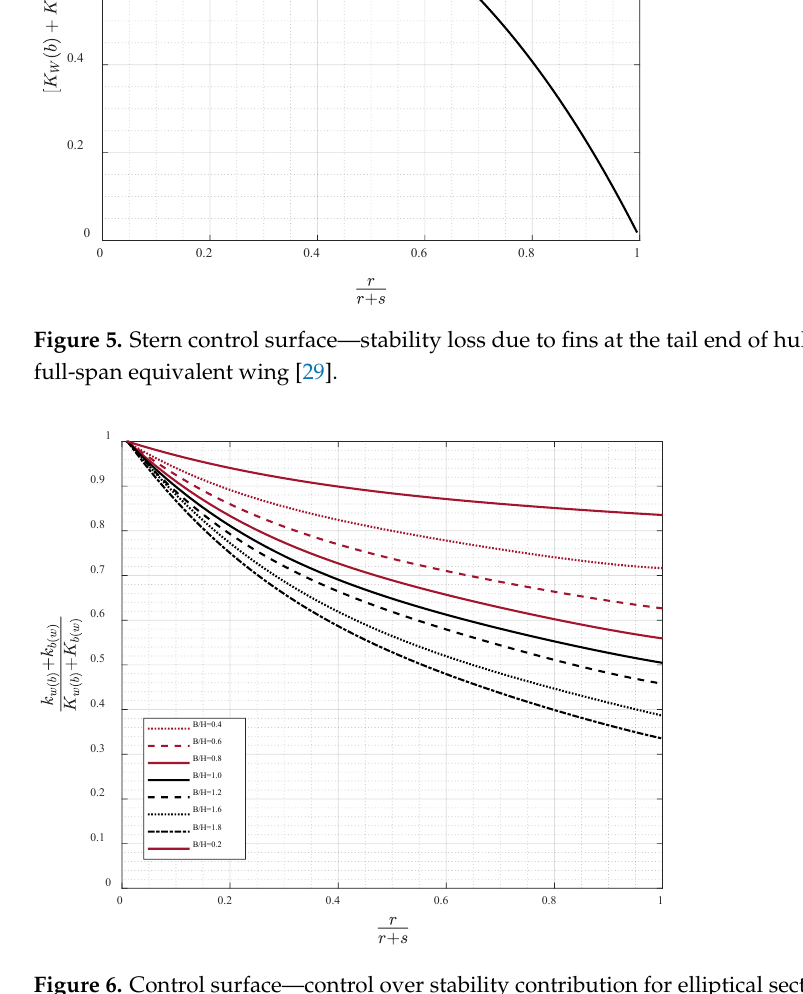
Figure 7. Control surface—interaction factors for fins on cylindrical bodies of circular section [29].